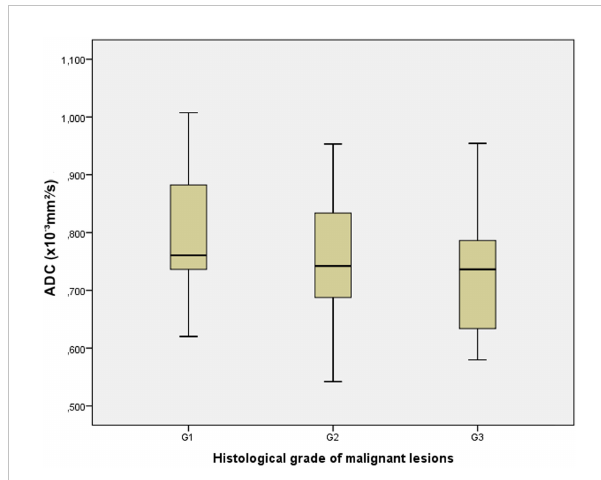
FIGURE 7 The box-and-whisker plots show the ADC values in different histological grades (G1, G2, and G3) of malignant